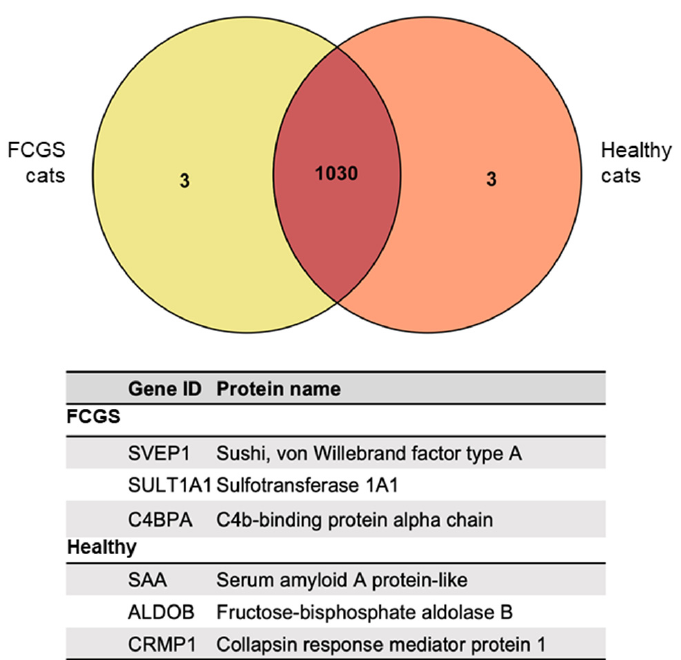
Figure 2. Venn diagram showing the proteins exclusively found in the secretome of healthy cats and those only found in FCGS-positive cats.